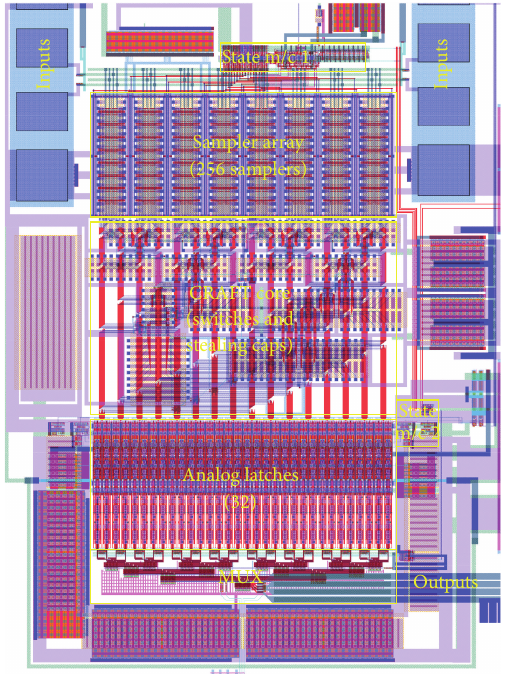
Figure 13: Layout of the CRAFT implementation and on-chip test